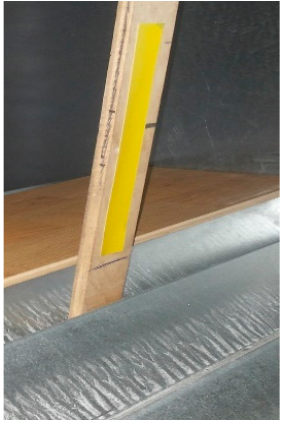
Figure 2. Water-sensitive paper position (in direction of the y axis from corrugated tin) in the wind tunnel.